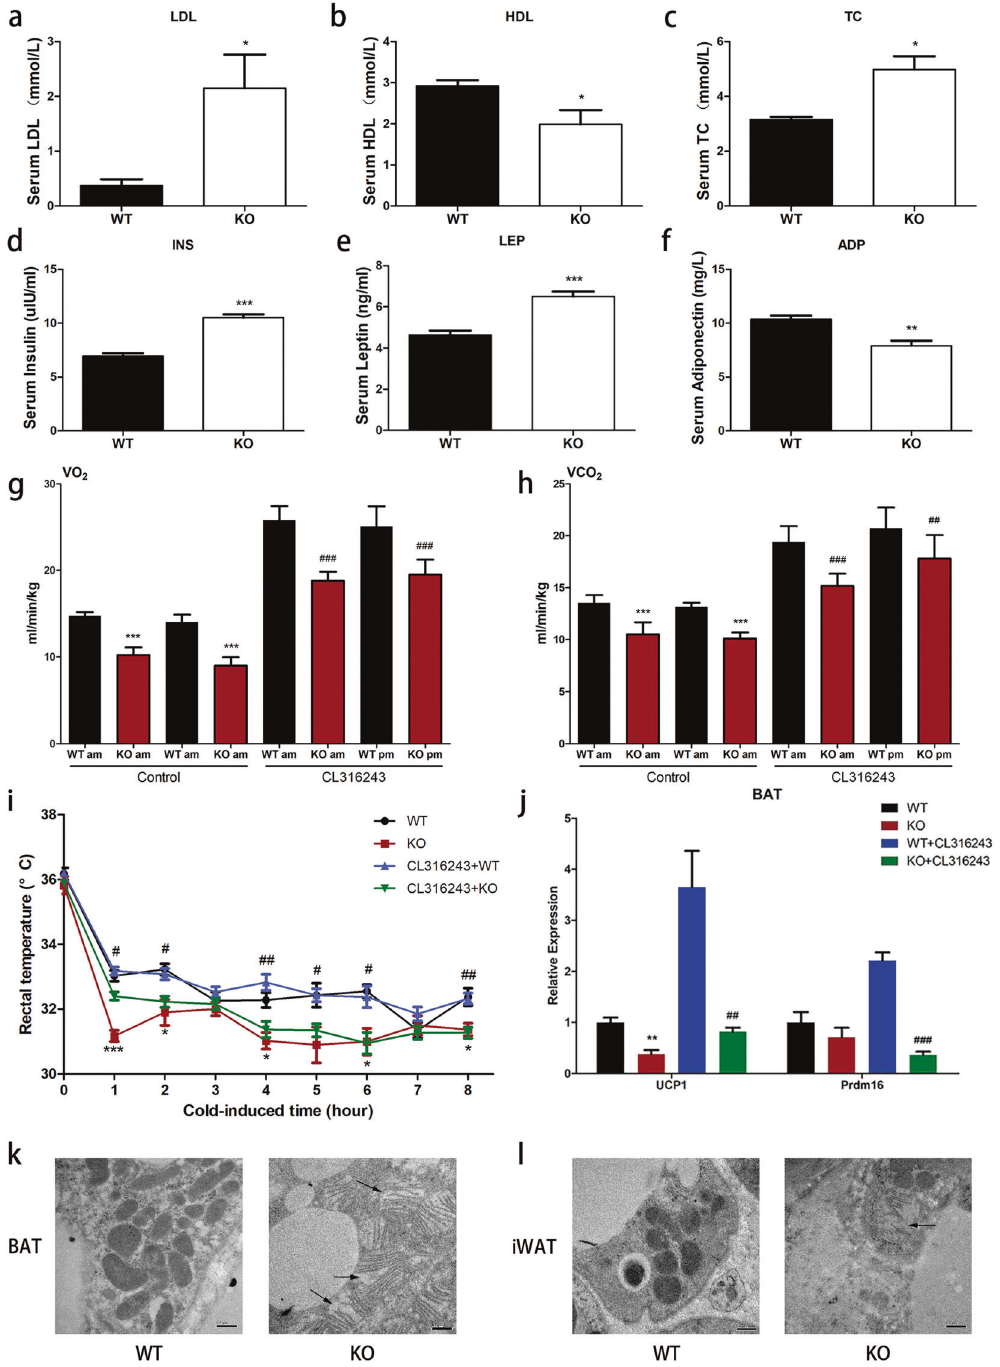
Fig. 3 Mitochondrial structural damage of brown adipose in Trib1 -knockout mice. Serum LDL ( a ), HDL ( b ), TC ( c ), insulin ( d ), leptin ( e ), and adiponectin ( f ) levels in Trib1 -wild-type and knockout mice. Energy expenditure was evaluated by measurement of oxygen consumption ( g ) and carbon dioxide release ( h ) in Trib1 KO and WT mice treated with CL316243 or not. After 8 h of cold exposure, the rectal temperature ( i ) of Trib1 KO and WT mice treated with CL316243 or not. j The mRNA level of thermogenesis-related genes in BAT from Trib1 KO and WT mice treated with CL316243 or not. TEM images of BAT ( k ) and iWAT ( l ) from Trib1 -knockout mice treated with CL316243 or not. Black arrows indicated abnormal mitochondria. Scale bar: 0.5 μ m. LDL, low-density lipoprotein; HDL, high-density lipoprotein; TC, total cholesterol; UCP1, uncoupling protein 1; Prdm16, PR/SET domain 16; BAT, brown adipose tissue; iWAT, inguinal white adipocyte tissue. In the bar fi gure, each data represents mean ± SEM ( n = 5). Indicated comparisons were made using Student ’ s paired t -test, * P < 0.05, ** P < 0.01, *** P < 0.001 over Trib1 WT mice; # P < 0.05, ## P < 0.01, ### P < 0.001 over Trib1 WT mice treated with